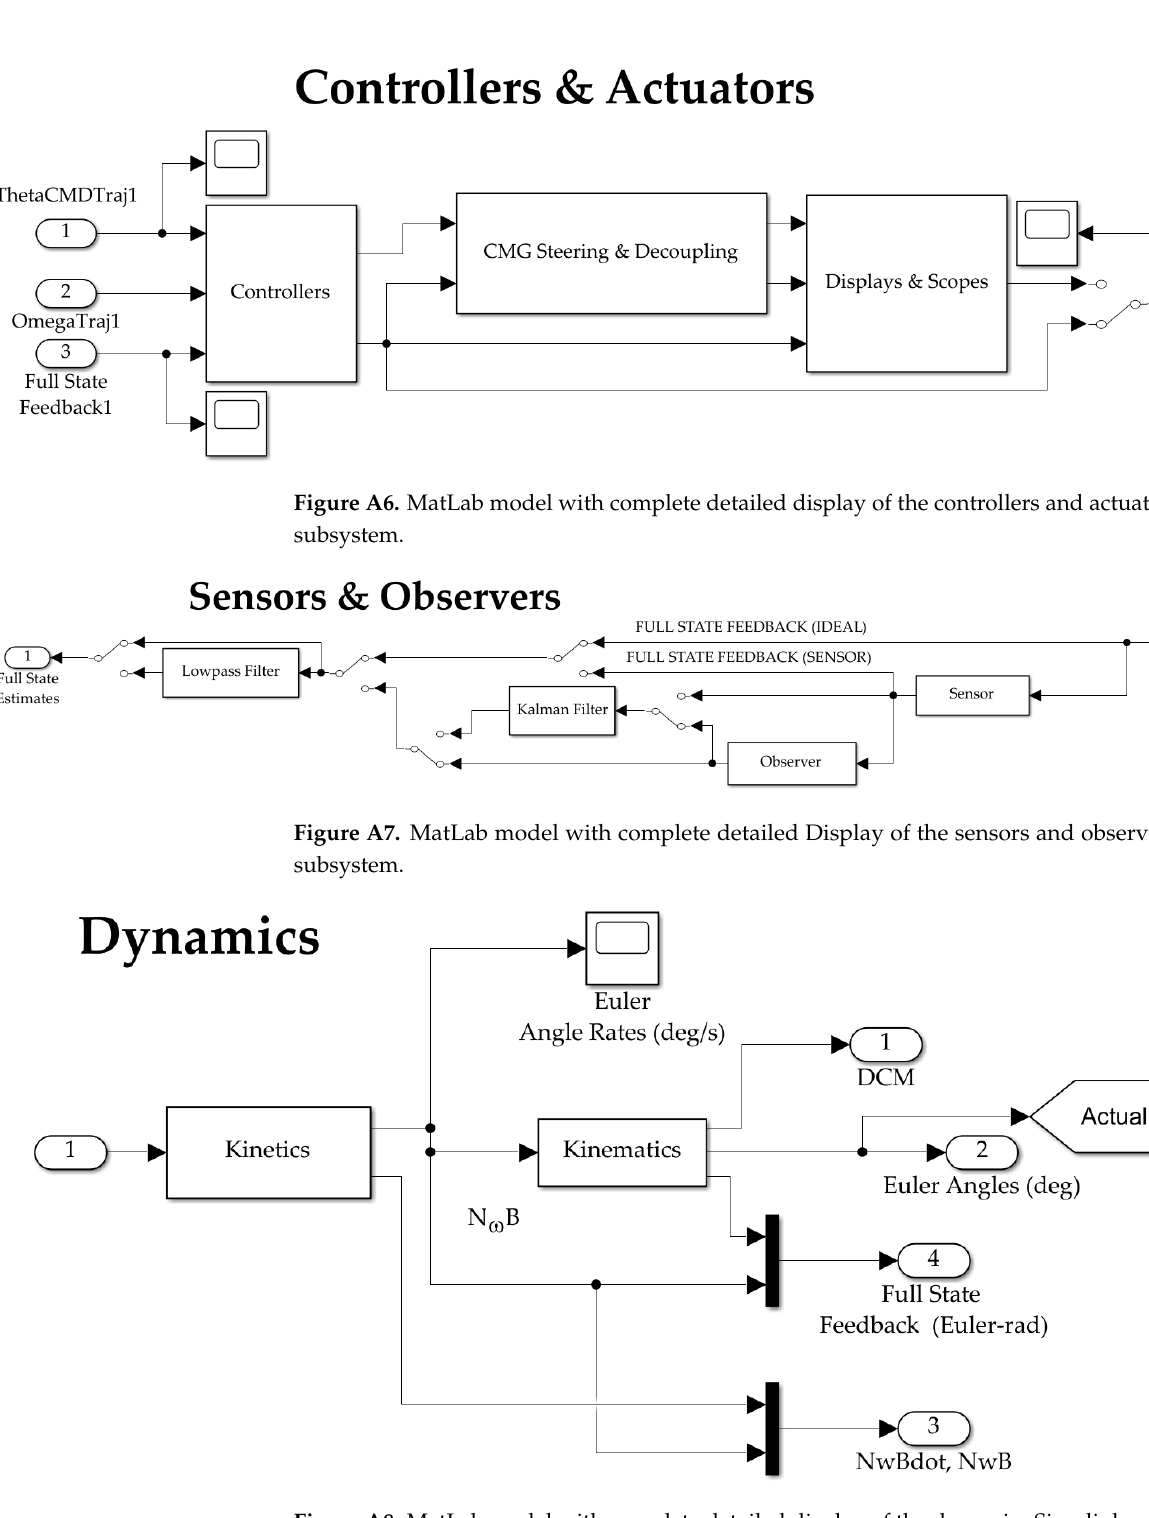
Figure A8. MatLab model with complete detailed display of the dynamics Simulink